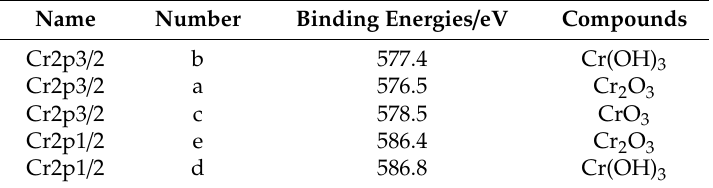
Table 2. The curve fitted by XPSPEAK corresponds to the compound in NIST.